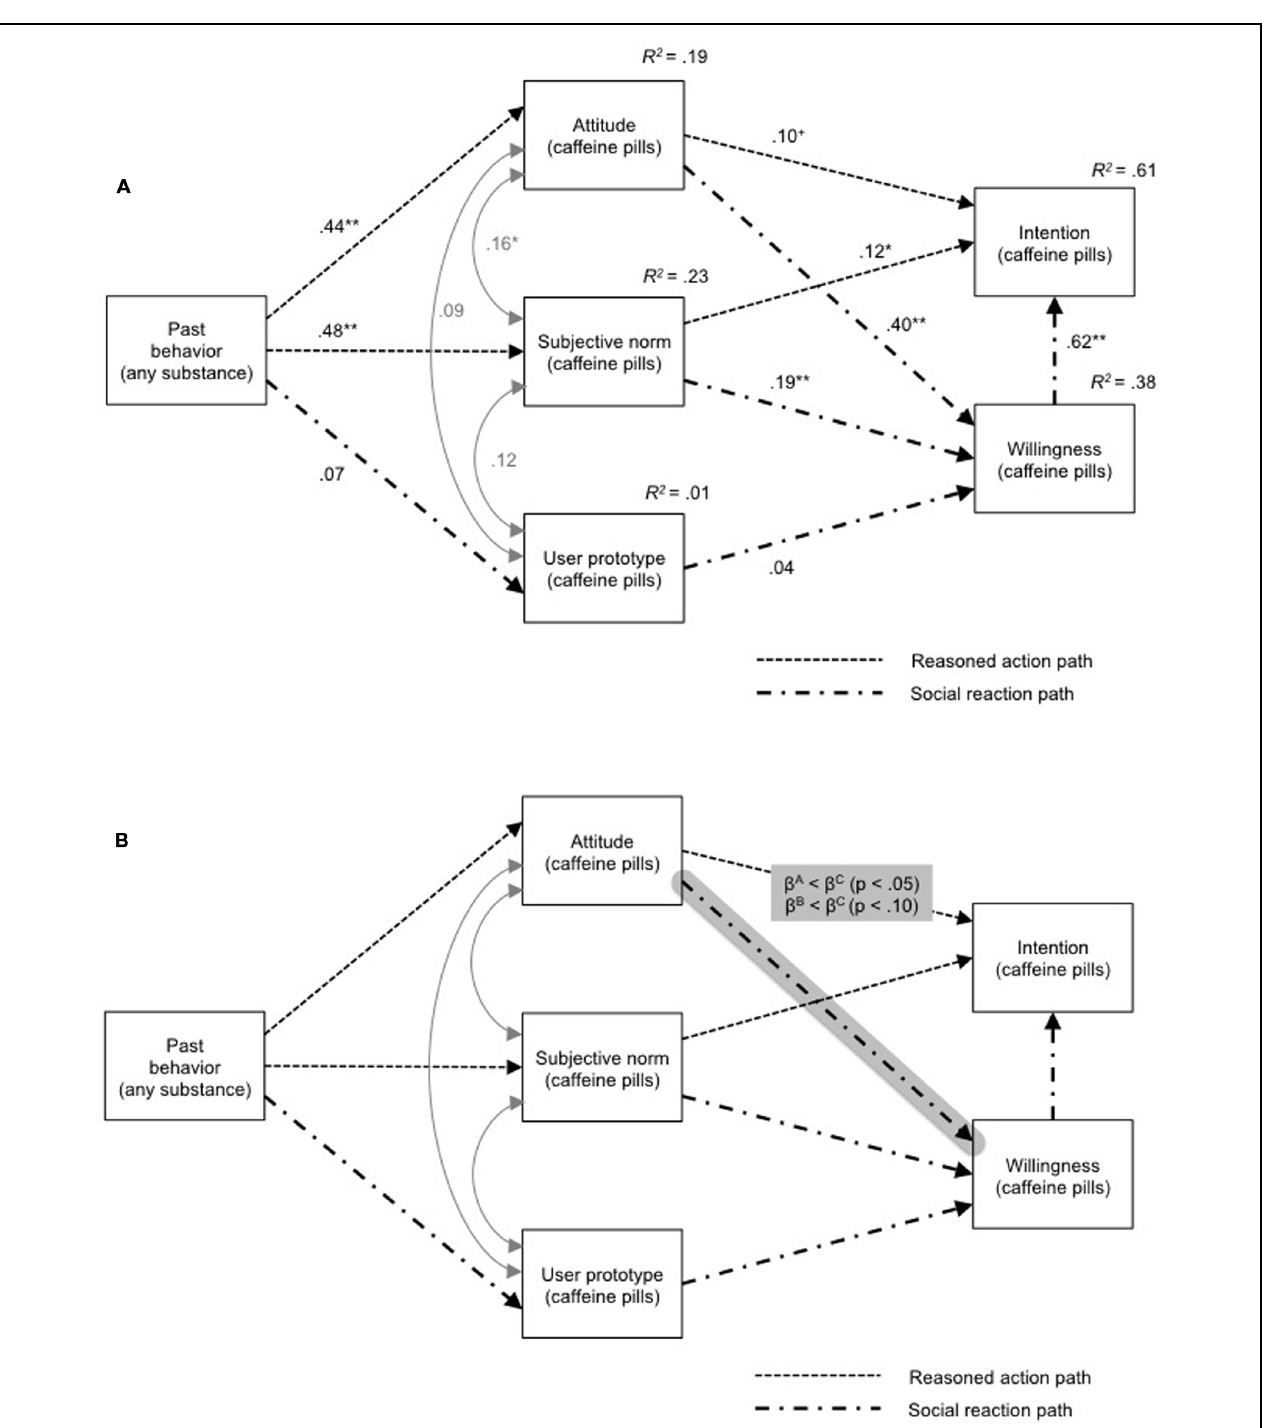
FIGURE 2 | The Prototype Willingness Model (Gibbons et al., 2009) with results from SEM in (A) ( R 2 for PWM variables and β stand . for paths) and the illustration of experimental effects (B).